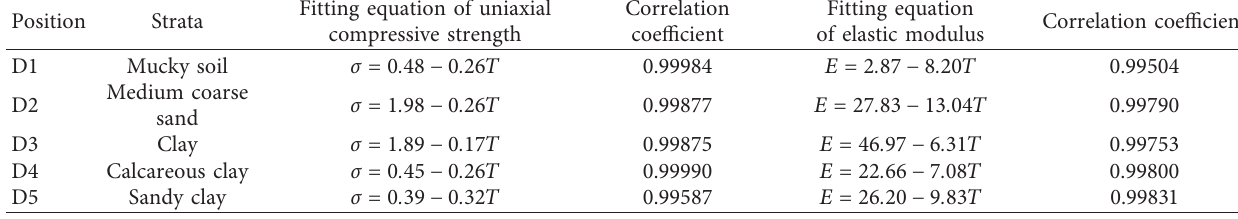
Table 5: Fitted curves for uniaxial compressive strength and elastic modulus versus temperature for different geotechnical samples.